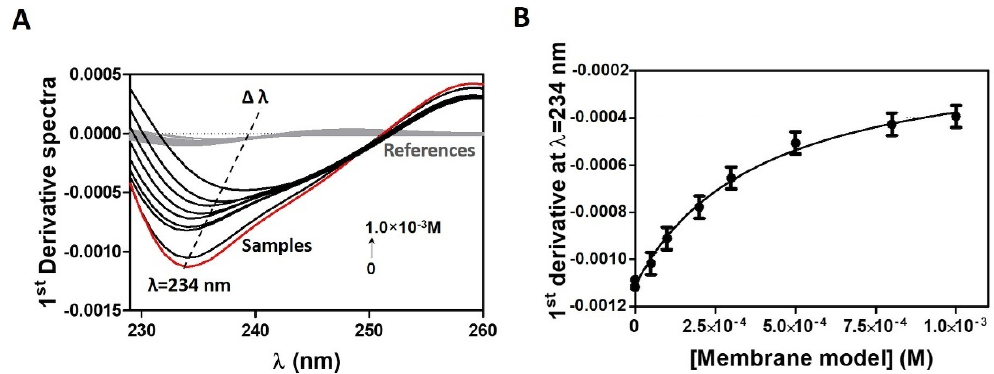
Figure 2. ( A ) First derivative of CPT (2 × 10 − 5 ) absorption spectra with increasing concentrations of cancer membrane models (0 to 1.0 × 10 − 3 M) in acetate buffer pH = 5.8. In red, are represented the absorption spectra of CPT in the absence of the cancer membrane models. With the addition of increasing concentrations of membrane model (samples represented in black), there is a shift in λ values. In grey, are represented the derivative spectra of the references containing only membrane models. ( B ) Nonlinear fitting of derivative absorbance values at λ = 234 nm as a function of membrane model concentration.